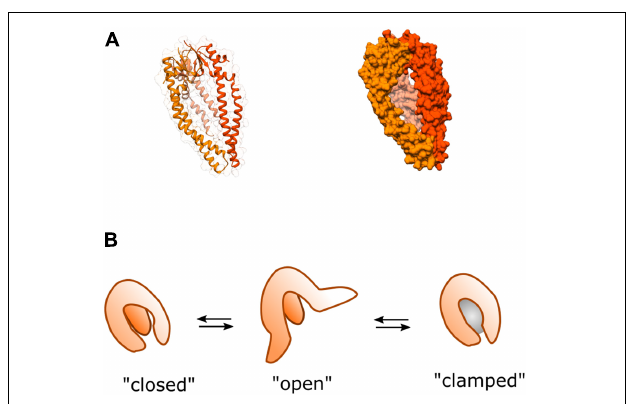
FIGURE 6 | Structure and dynamics of Skp. (A) Cartoon (left) and surface (right) representations of the crystal structure of homo-trimeric periplasmic chaperone Skp of E. coli PDB:1SG2 (Korndörfer et al., 2004). (B) A model of dynamic movements between conformations adapted from Holdbrook et al. (2017). The three tentacular arms function to clamp around substrates of different sizes (represented by the gray sphere) binding them in the hydrophobic core to prevent aggregation, or rescue partially aggregated proteins.